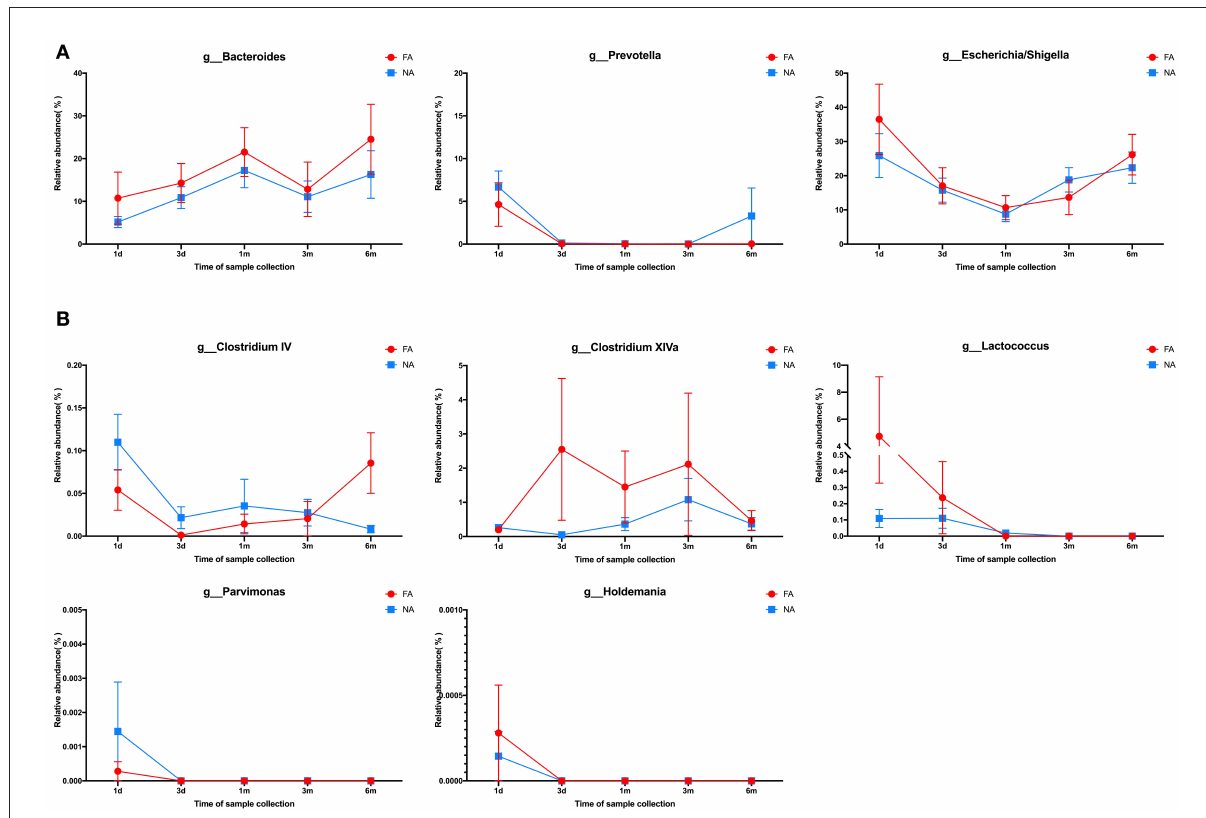
FIGURE8 (A) Changes in the maternal main gut microbiota in late pregnancy compared with the infant gut microbiota over time. (B) Changes in the maternal differential gut microbiota in late pregnancy compared with infant gut microbiota over